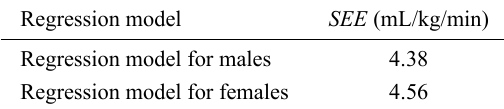
Table 9. Results of the validity